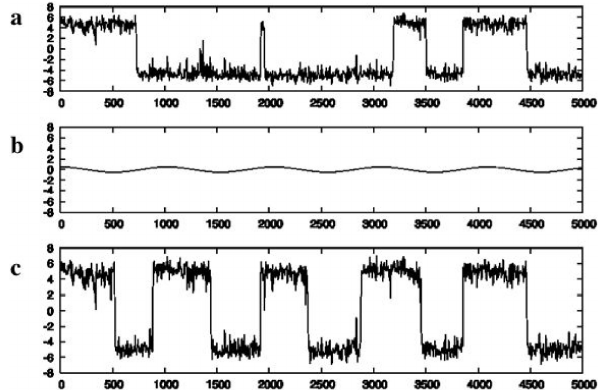
Fig. 3. Numerical simulation of Eq. (7) in three different cases. In the upper panel, we show the solution with the noise and A = 0. In the middle panel we show the perturbing forcing A cos ( 2 πωt) while in the lower panel we show the solution with A = 0 . 1. The effect of the small periodic forcing is to synchronize the random switching from one climate states to the other, i.e. to get a stochastic